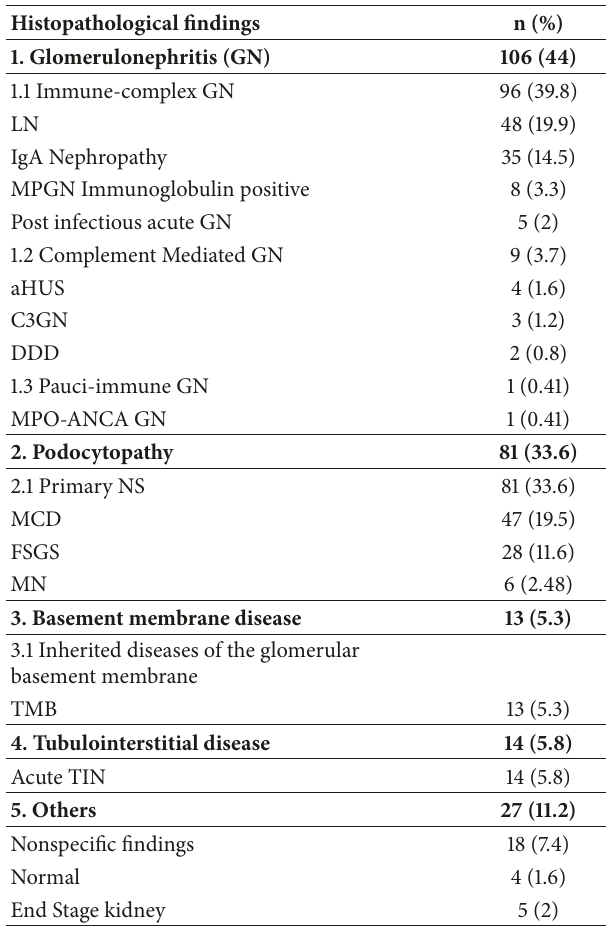
Table 4: Distribution of histopathological